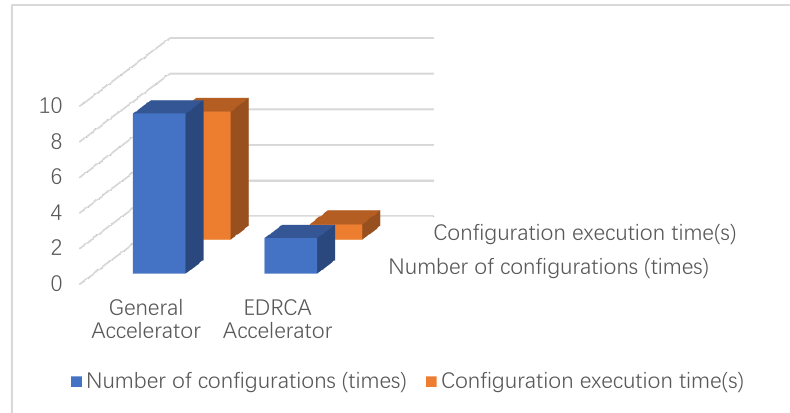
Figure 7. Comparison of EDRCA and general accelerator.